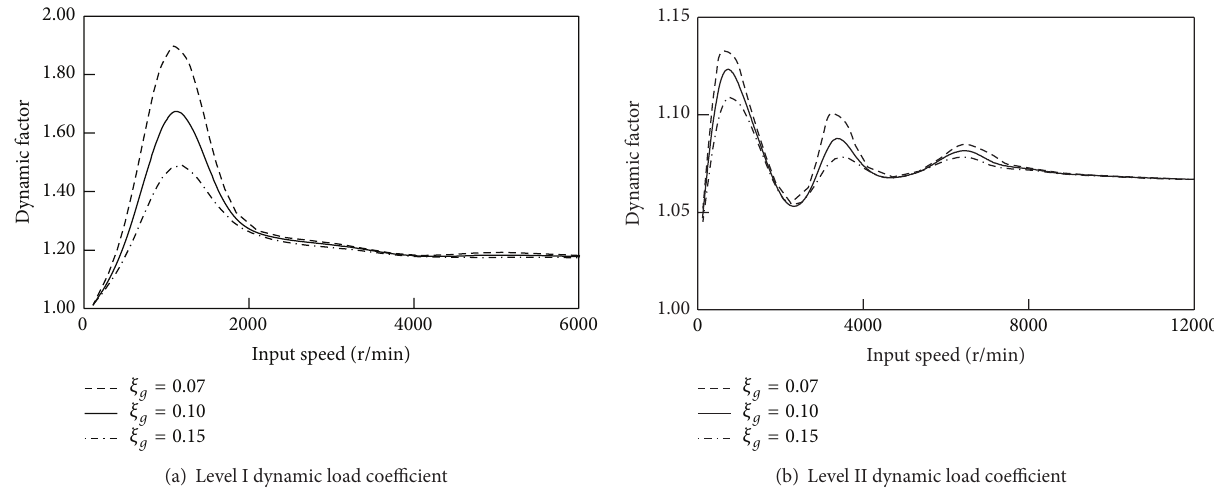
Figure 12: The relationship between the dynamic factor and speed.